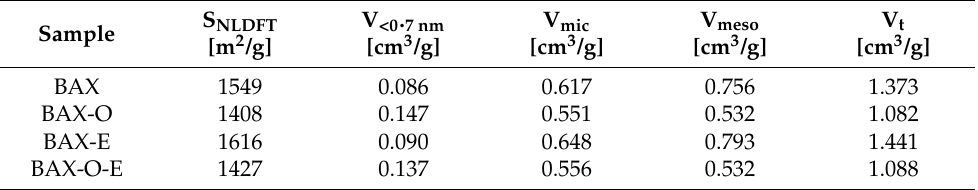
Table 1. Parameters of the pore structure of BAX and BAX-O and their counterparts exposed to ammonia in dynamic conditions. S NLDFT -surface area calculated using a NLDFT approach [38]; V <0 . 7 nm -volume of ultramicropores; V mic -volume of micropores; V meso -volume of mesopores, V t - total pore volume, calculated from nitrogen adsorption isotherms). Adapted with permission from Reference [20]. Copyright 2015, The Royal Society of